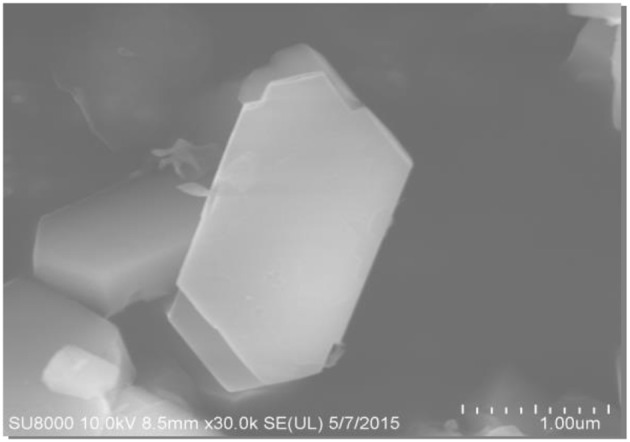
SEM of fresh ZSM-5.